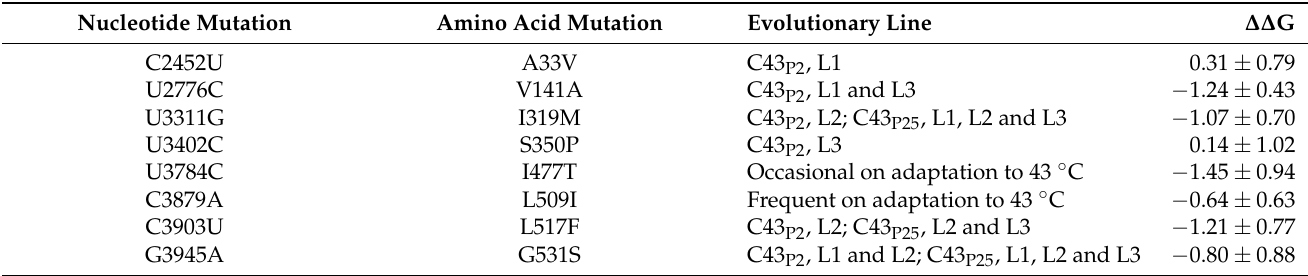
Table A1. High-abundance non-synonymous mutations in the replicase of the Q β phage adapted to 43 ◦ C. Experiments were performed in triplicate, and L1, L2, and L3 indicate that each of the three independent lines simultaneously evolved. The initial Met amino acid is not considered in the enumeration of amino acid positions. The last column shows the average and standard deviation of changes in the folding free energy of the protein with that mutation with respect to the sequence without it, estimated through six different PSP algorithms. See the main text and the Materials and Methods for